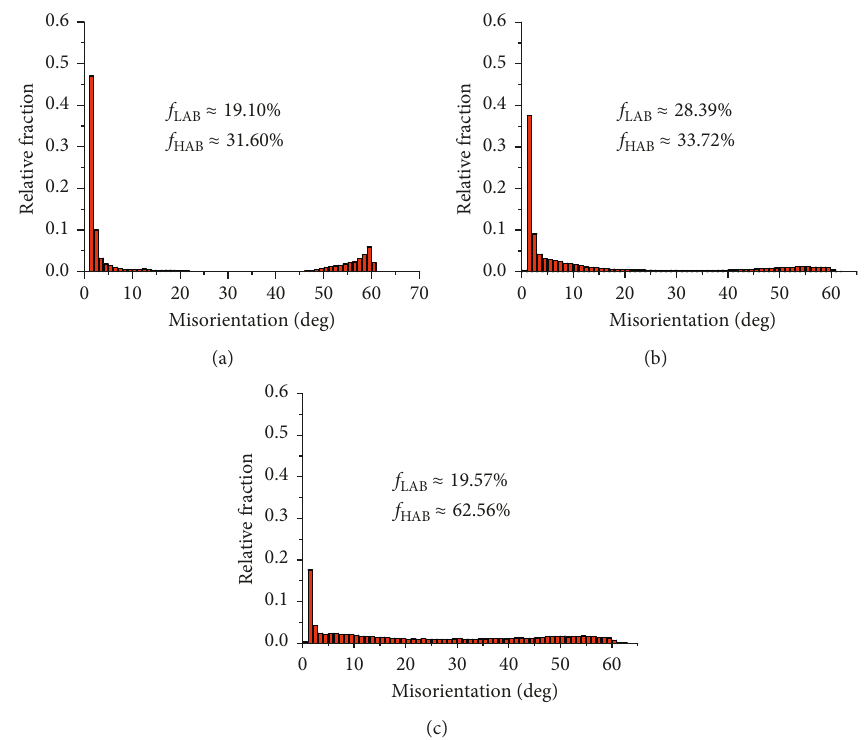
Figure 7: The fractions of LABs and HABs in (a) sample 4, (b) region 2 of sample 2, and (c) region 3 of sample 3. Rotation direction Roll-beating wheel